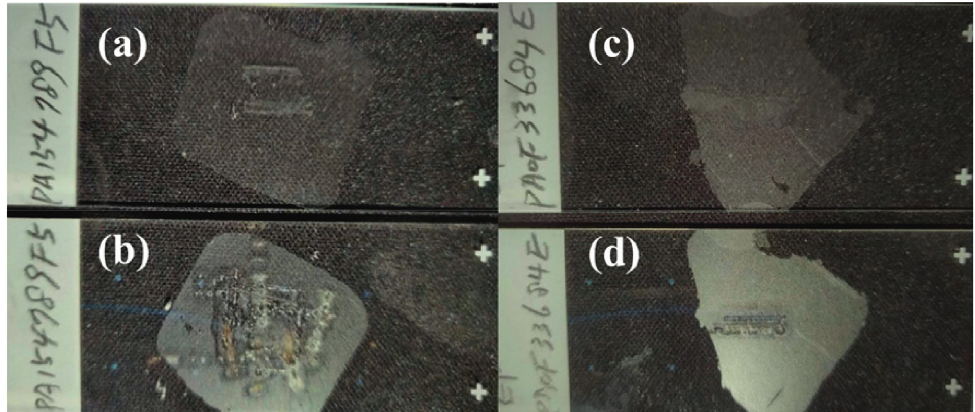
Figure 2: The images of FFPE normal and melanoma tissues on glass slides, before and after laser ablation: (a) normal FFPE tissue before laser ablations; (b) after laser ablation; (c) melanoma FFPE tissue before laser ablations; (d) after laser ablation, also laser-ablated